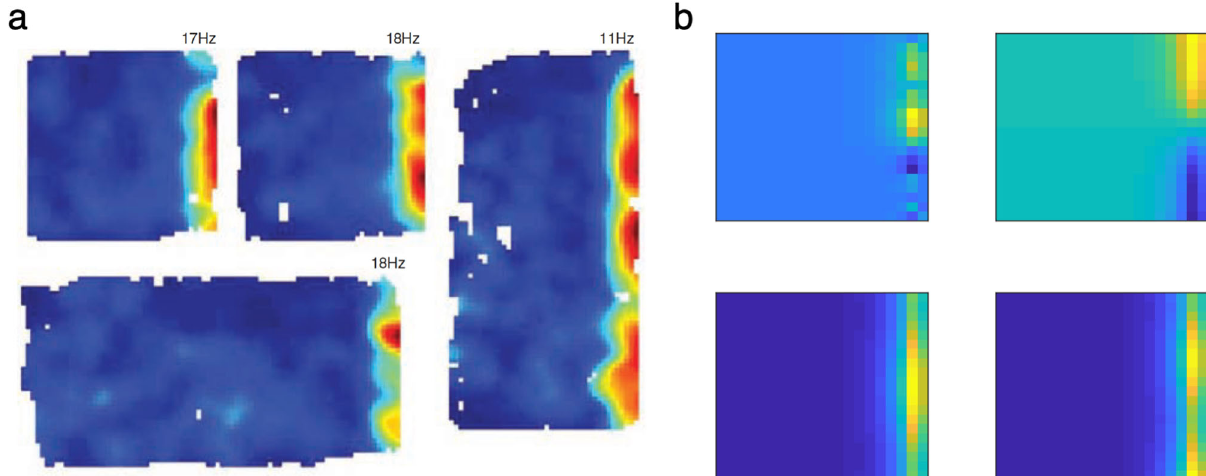
Fig. 5 The model explains border cells. a Rate maps for a representative border cell in different boxes; adapted from Solstad et al. 41 with permission from AAAS. b Columns of the matrix required to update the DR matrix to account for the wall resemble border cells. Four example columns from a 20 × 20 maze are plotted. See also Supplementary Fig. 2. Source data are provided as a Source Data fi le.